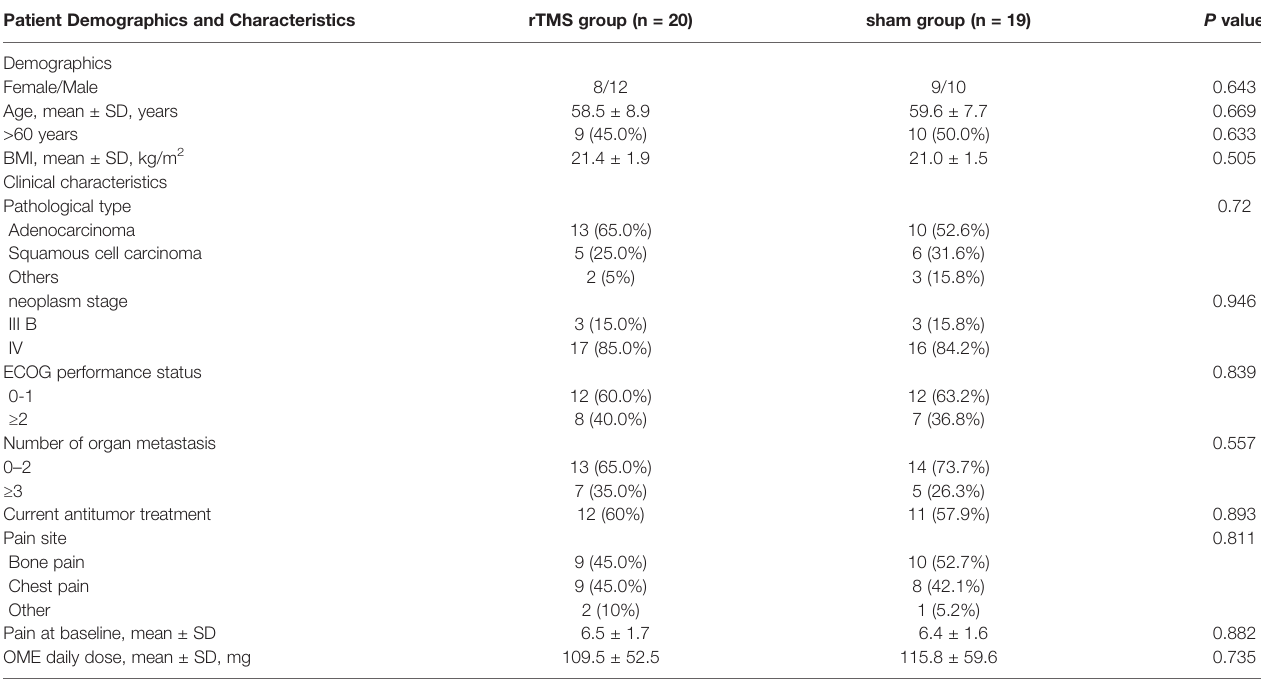
TABLE 1 | Baseline Demographics and Clinical Characteristics by